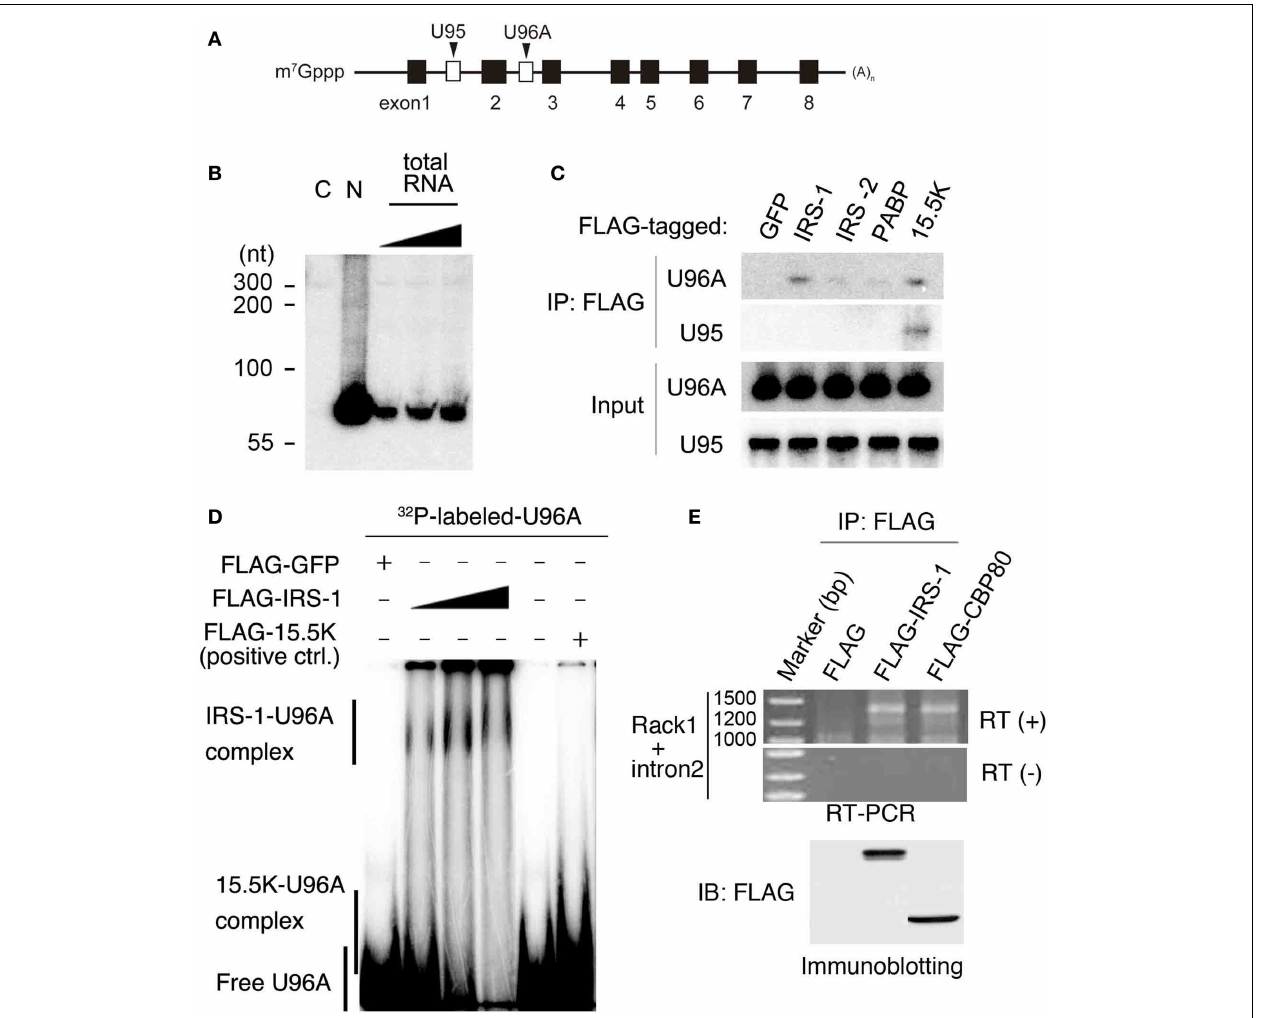
were subjected to Northern blotting with the indicated probes. Representative results from three independent experiments are shown.